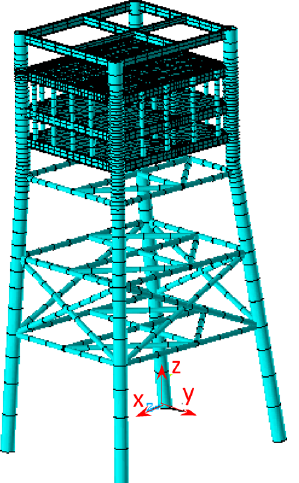
Fig. 10 Finite element model of the